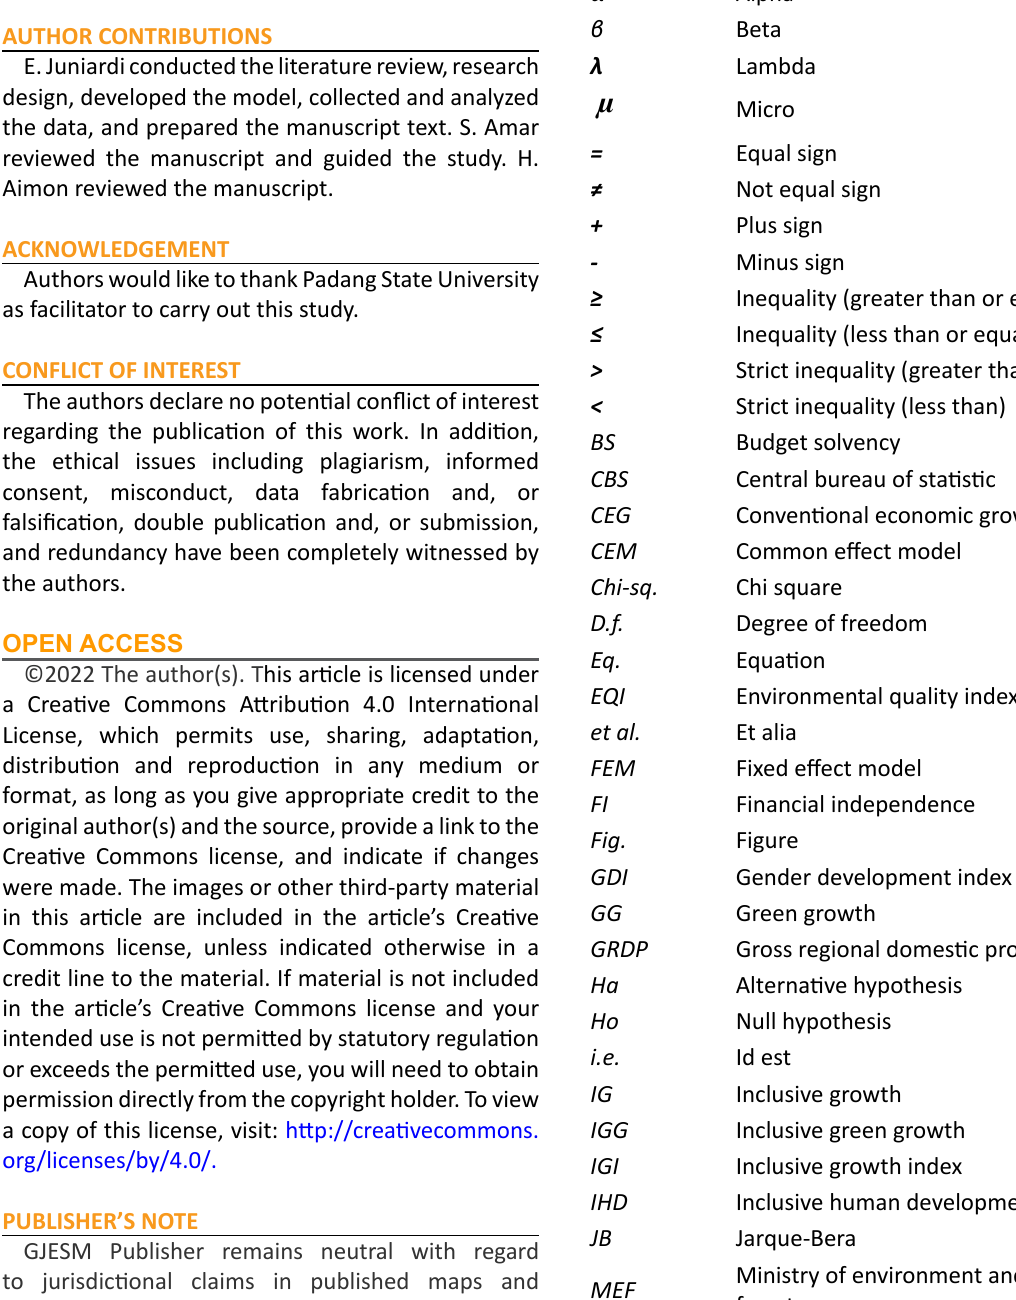
GDI Gender development